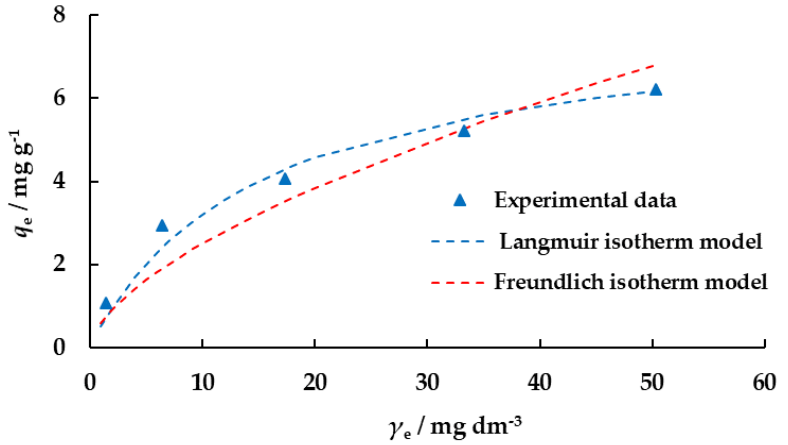
Figure 10. Langmuir and Freundlich isotherms of CR biosorption on EP ( γ biosorbent = 8 mg dm − 3 , t = t = 360 min, pH = 7, T = 298.15 K, v = 150 360 min, pH = 7, T = 298.15 K, v = 150 rpm). Table 2. Isotherm parameters for the removal of CR by EP at 298.15 K.